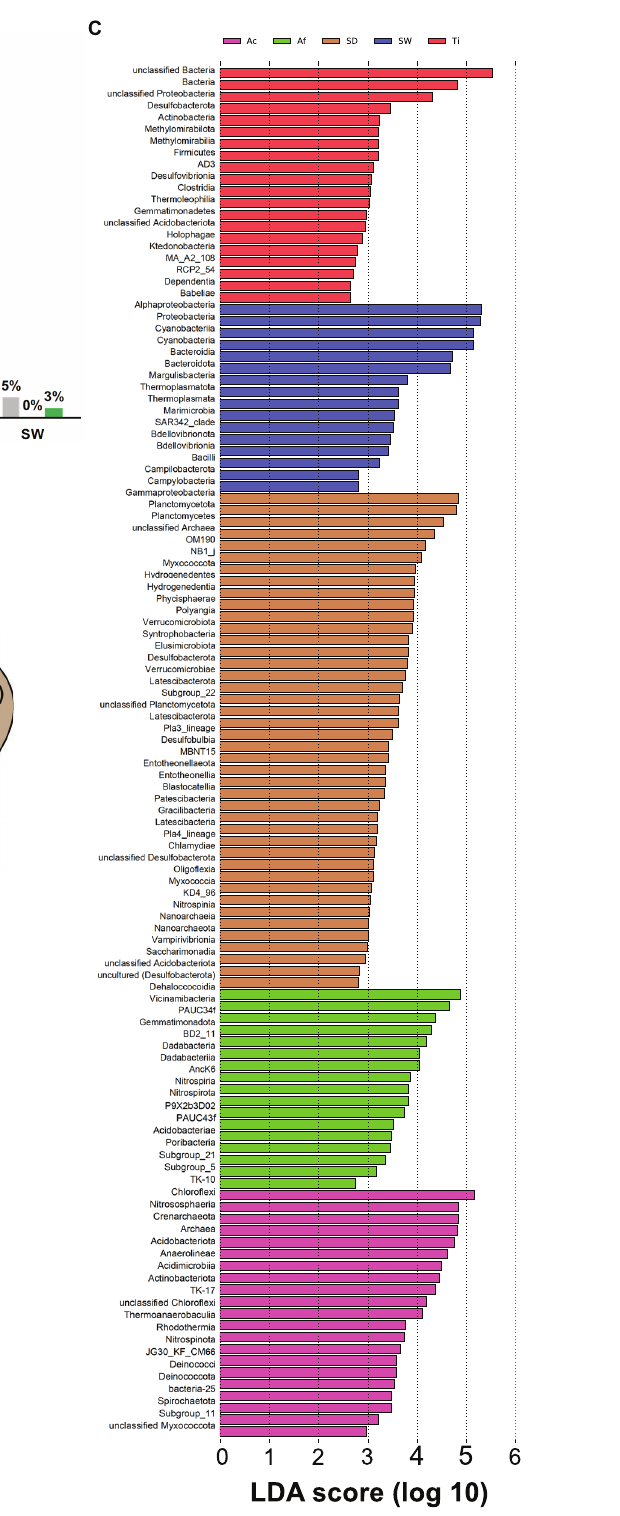
FIGURE 3 | The modified stochasticity ratio (MST) of prokaryotic community under different groups. Ac ( Aplysina caissara ), Af ( Aplysina fulva ), Ti ( Tedania ignis ), SW (seawater), and SD (sediment) (A) , venn diagram with all OTUs detected in Ac (magenta), Af (green), Ti (red), SW (blue), and SD (brown) (B) , and taxonomic representation of statistically and biologically consistent differences across Ac, Af, Ti, SW, and SD (C)